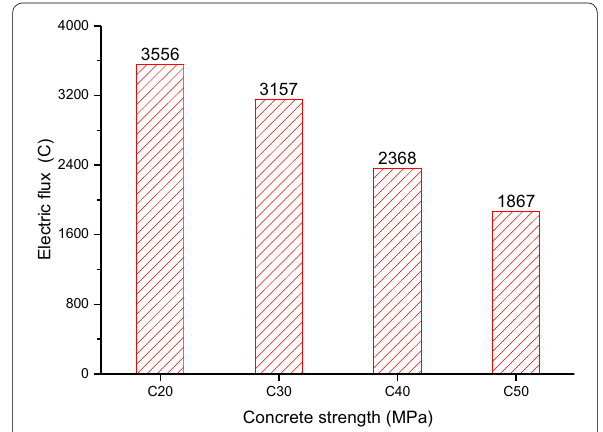
Fig. 13 Electric flux of different concrete